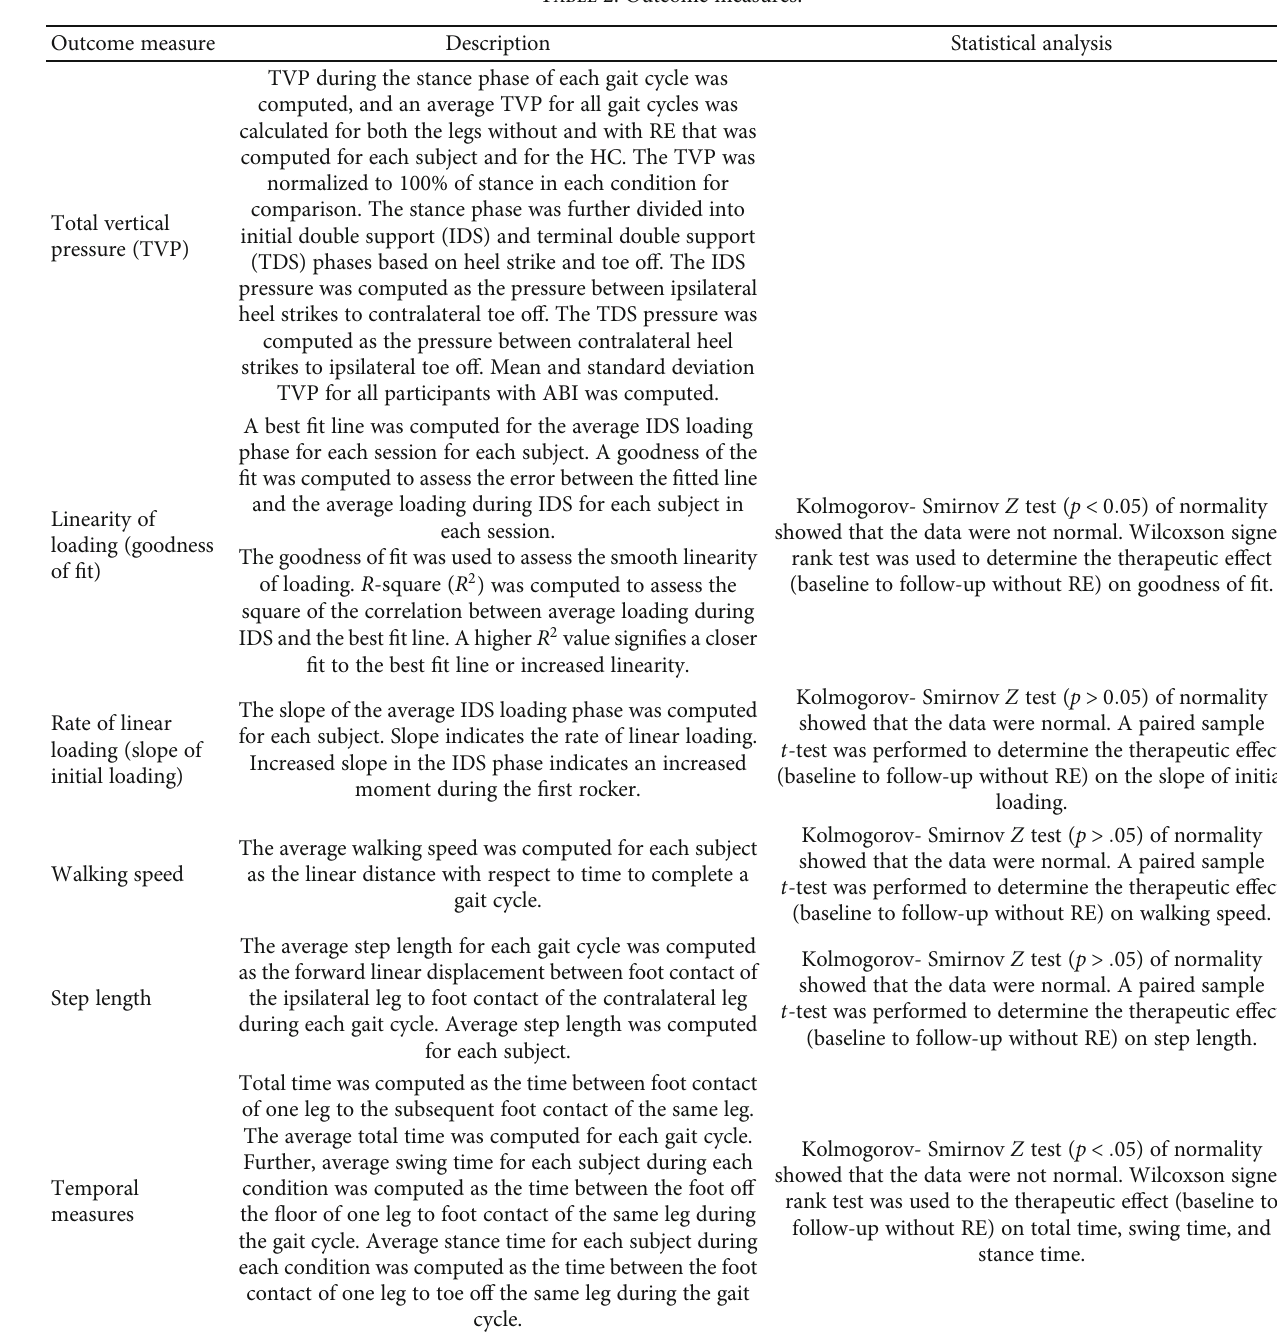
Table 2: Outcome